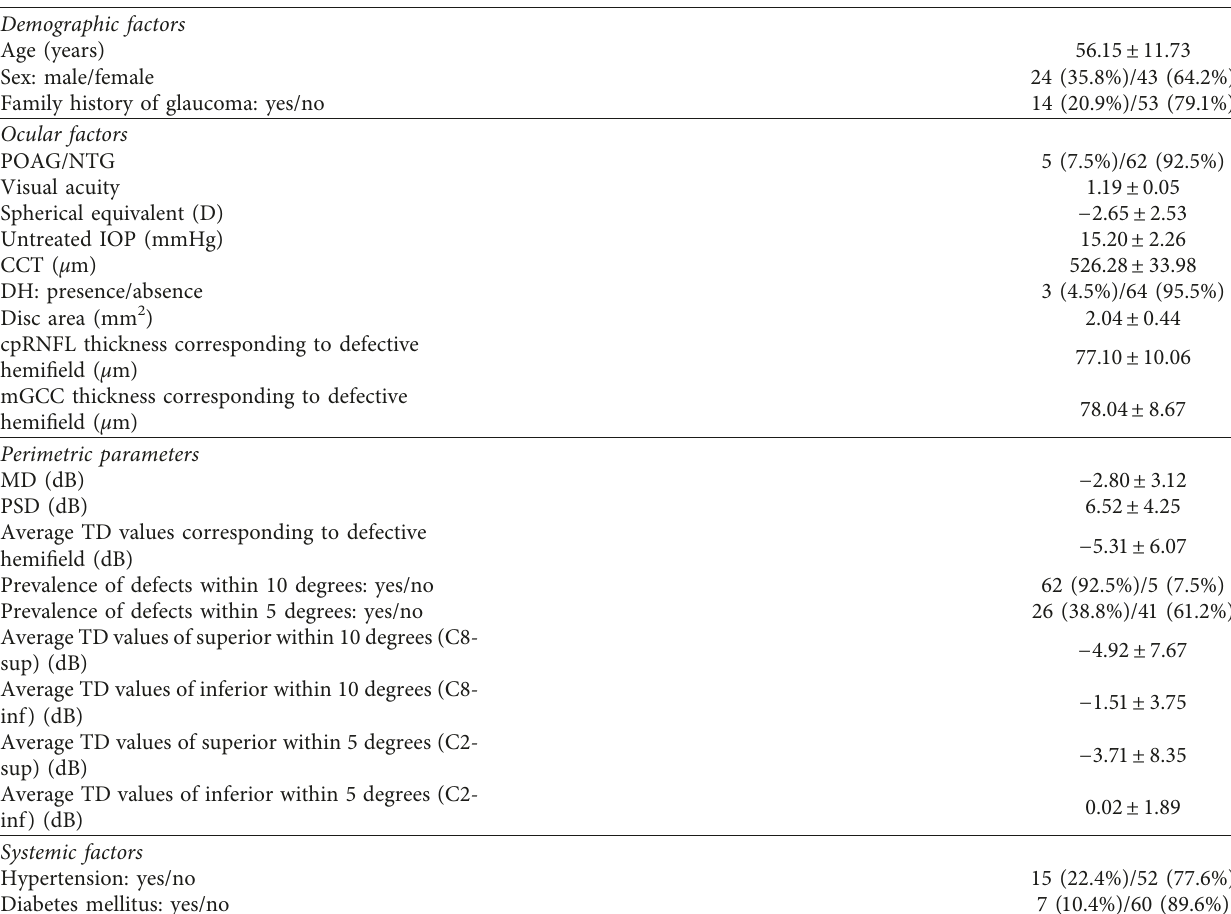
Table 1: Patient